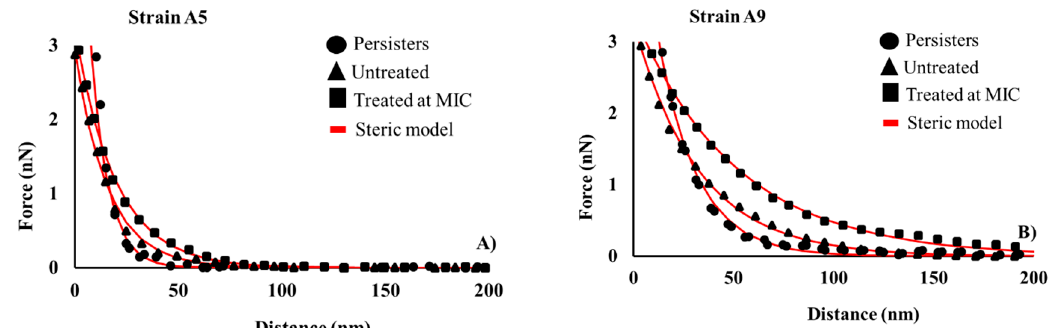
Figure 10. ( A , B ) Representative examples of how the steric model (red lines) fits the experimental data (symbols) for Strains A5 and A9 at different treatment conditions. The average r 2 for A5 was 0.95 and for A9 was 0.92.